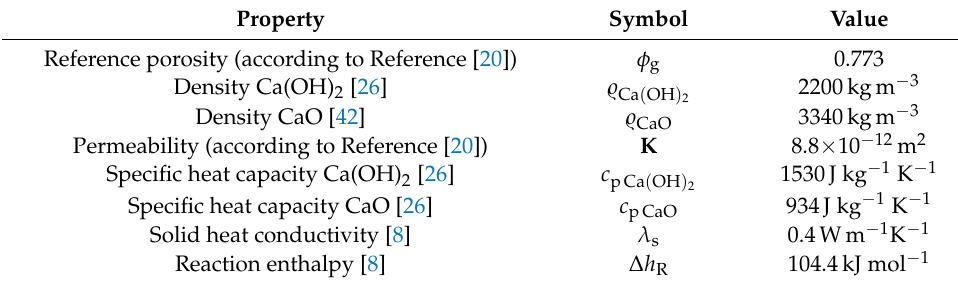
Table 2. Material parameters. Property Symbol